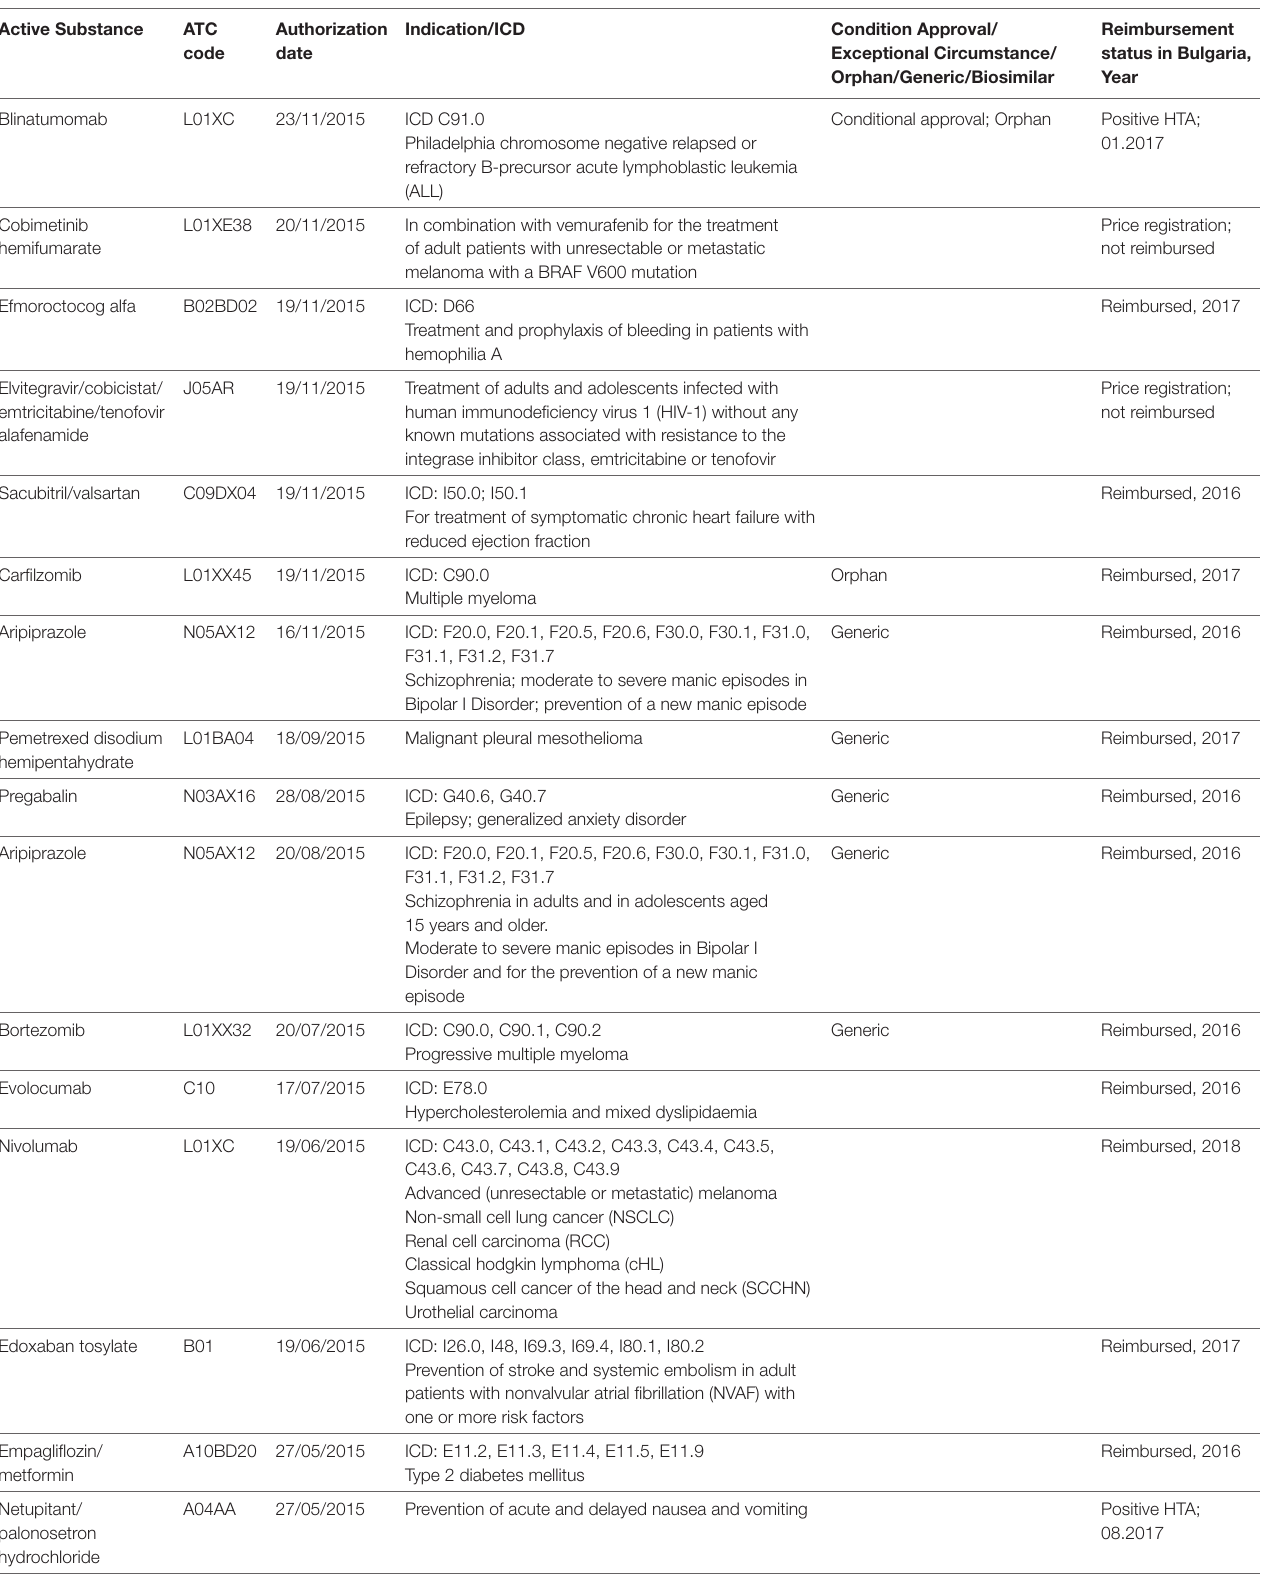
TaBle 1 | Medicinal products with centralized marketing authorization, which are available in